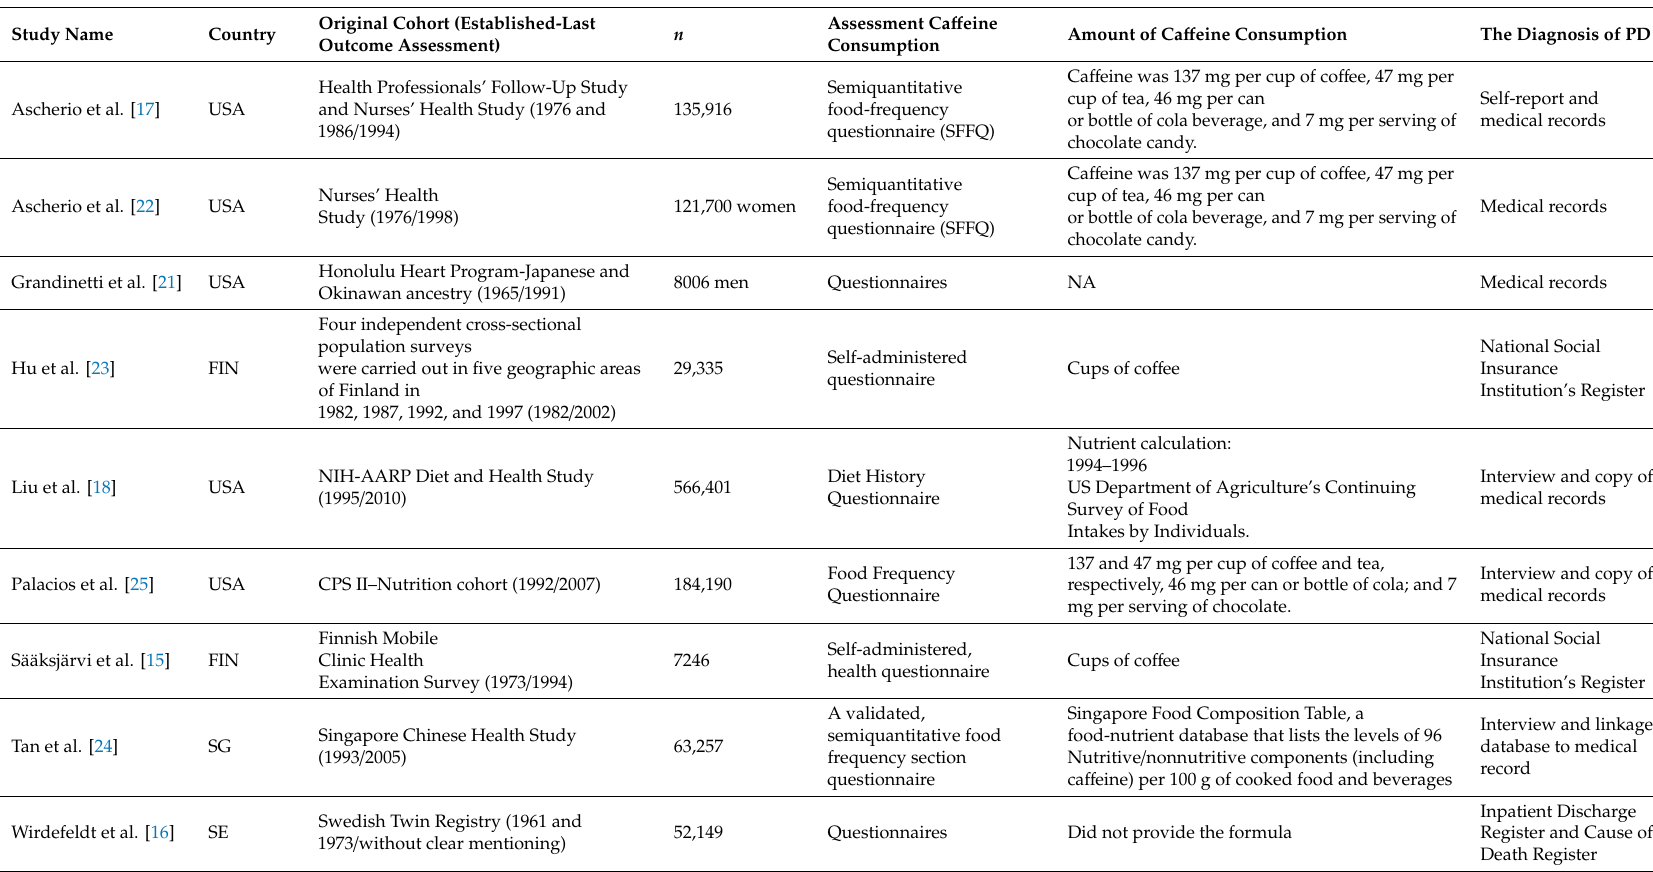
Table 1. List of the included cohort